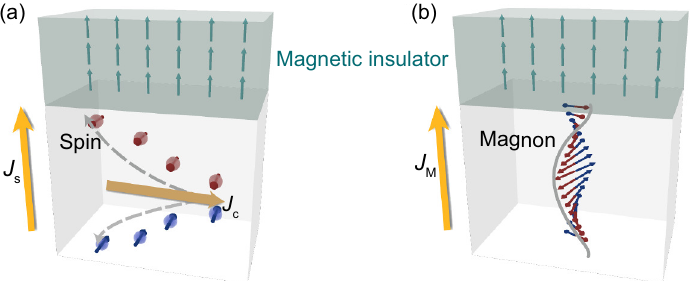
Figure 1. Schematic of the MI magnetization manipulated by ( a ) the electrical SOT via the electrical spin current J s , and ( b ) the magnon torque via the magnon current J M